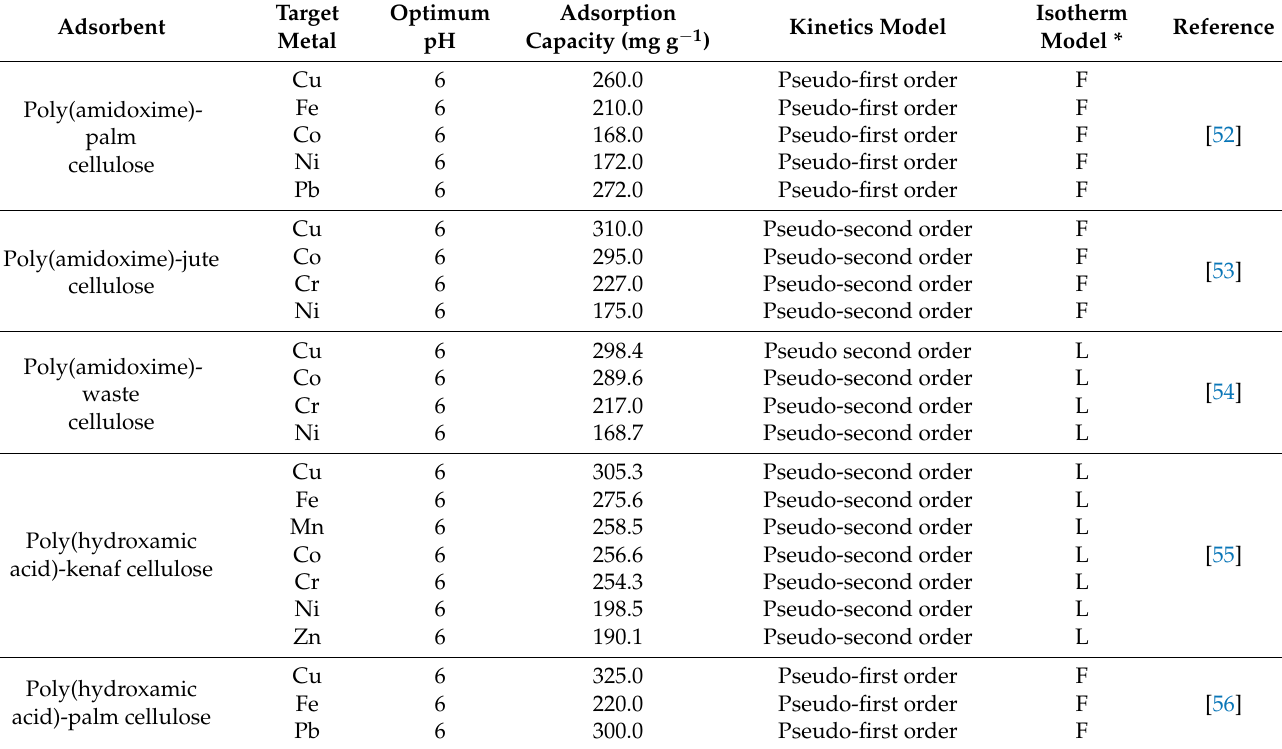
Table 10. Heavy metal adsorption capacities of various polymer-based